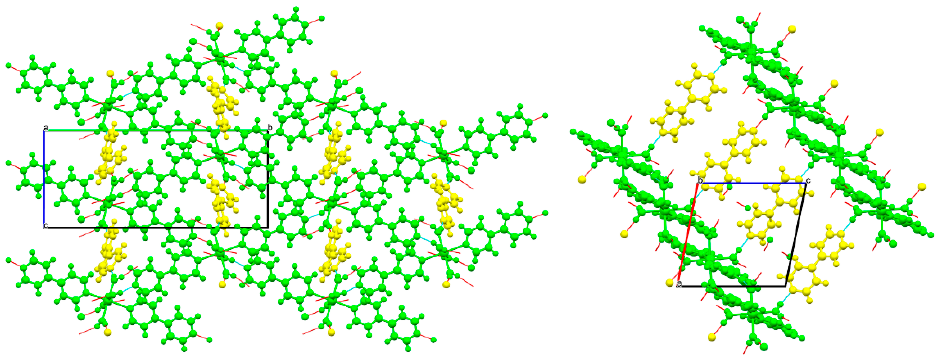
Figure 7 . Packing diagrams of compound 2 (anions omitted) watched along a ( left ) and b ( right ). Color coding: green: the [Ca(H 2 O) 4 (4,4 ′ -bipy) 2 ] cations; yellow: the lattice bipyridines.